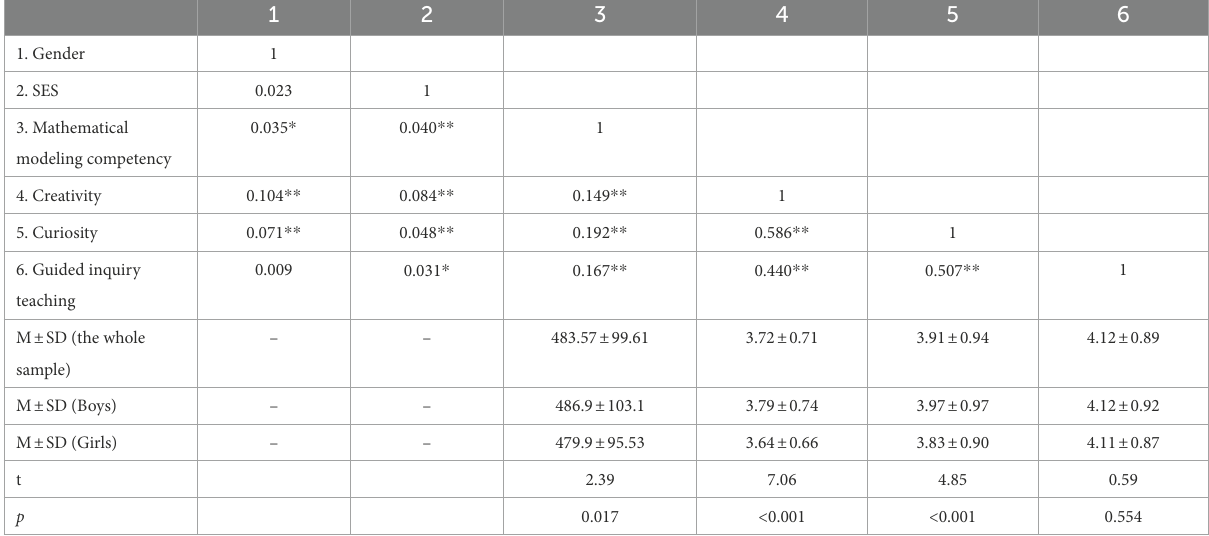
TABLE 1 Means, SDs, gender difference, and intercorrelations among key